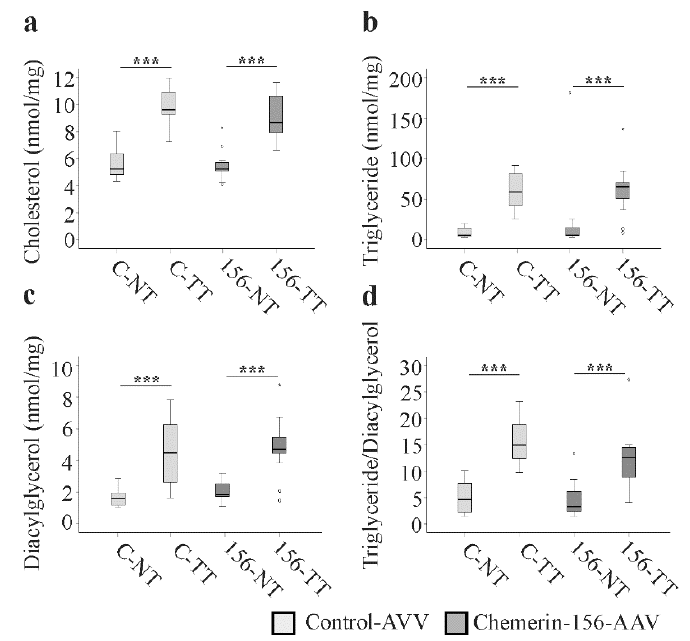
Figure 6. Lipids in hepatic non-tumorous (NT) and tumor tissue (TT) of control-AAV (C) and chemerin-156-AAV (156) infected mice. ( a ) Cholesterol. ( b ) Triglycerides. ( c ) Diacylglycerol. ( d ) Triglyceride to diacylglycerol ratio. Small circles in the figure indicate outliers greater than 1.5 times the interquartile range and small stars indicate outliers greater than 3.0 times the interquartile range. *** p < 0.001.